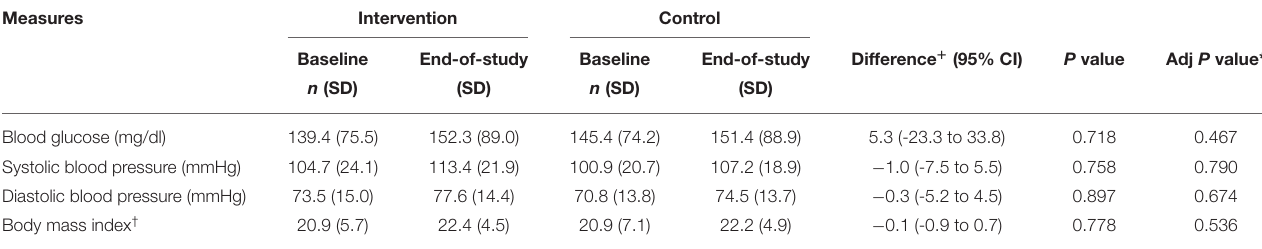
TABLE 2 | Outcome variables at baseline and end-of-study and differences between intervention and control group at the end of intervention. Measures